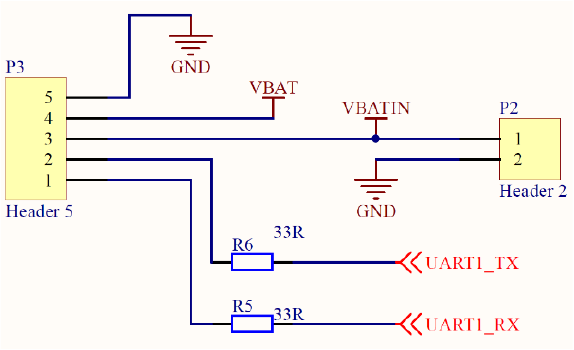
Figure 7. The circuit diagram of serial port and power interface.